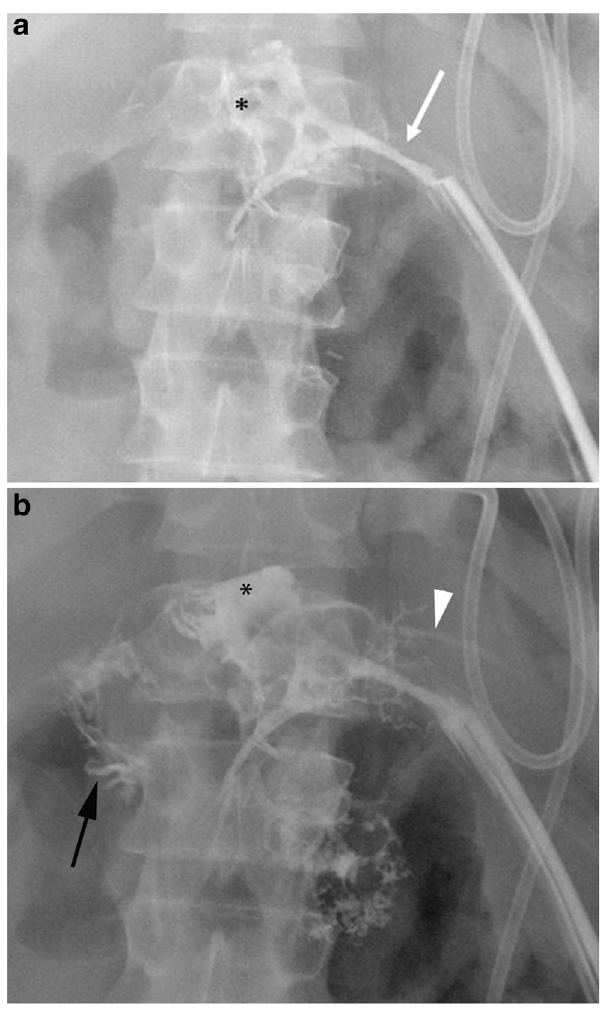
Fig. 16 Pancreatic fistula after the Whipple procedure. a , b Sequential images acquired during fistulography. Contrast medium is injected through a drainage on the left. Immediate filling of a fistulous tract (white arrow) and a collection (*) is seen. In the later phases passage of contrast medium inside the anastomotic loop becomes evident (black arrow in b ), findings diagnostic for an anastomotic dehiscence. The main pancreatic duct is visualised (white arrowhead in b )